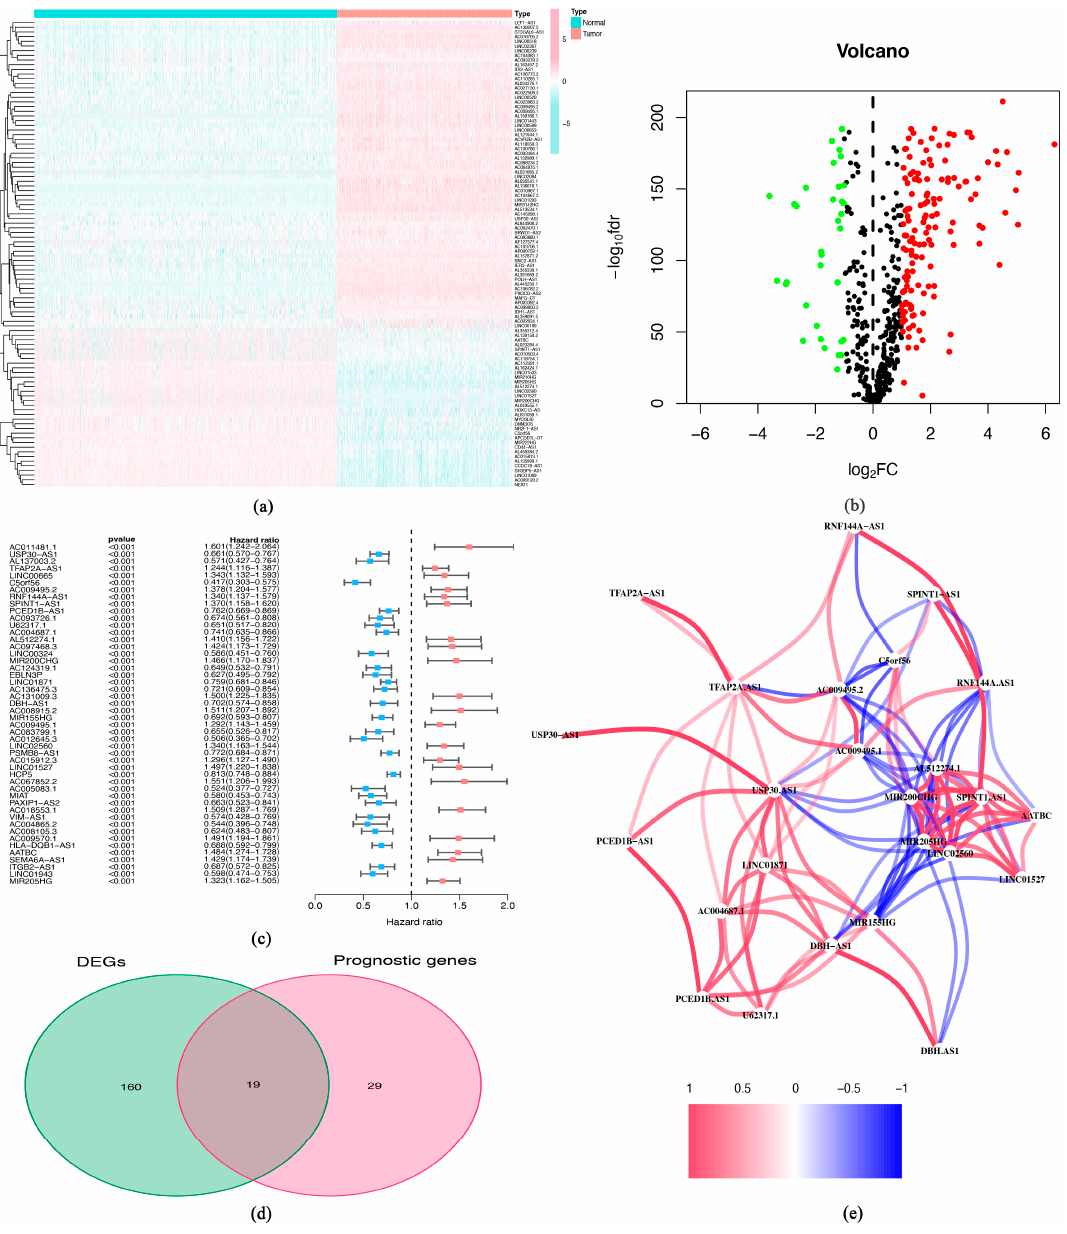
Figure 2. Identi fi cation of di ff erently expressed lncRNAs and prognostic-related lncRNAs. ( a , b ) Heatmap and Volcano plots were used to demonstrate the di ff erential expression of lncRNAs in normal and tumor tissues. In Volcano plots, the green plot represents down-regulated genes, the red plot represents up-regulated genes. ( c ) Univariate Cox regression was performed to identify forty-eight prognostic-related lncRNAs. ( d ) The intersection of di ff erently expressed lncRNAs and prognostic-related lncRNAs. ( e )The correlation network of intersected genes.